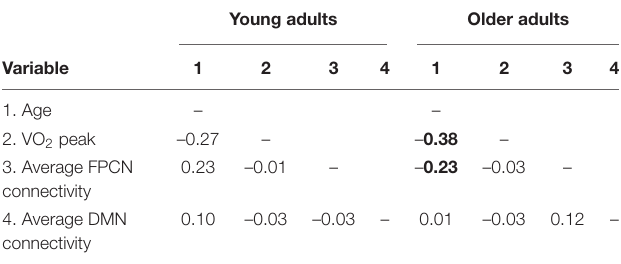
TABLE 3 | Correlation matrix for study variables used in regression analyses; correlations in bold are significant at the p < 0.05 level; FPCN, frontoparietal control network; DMN, default mode